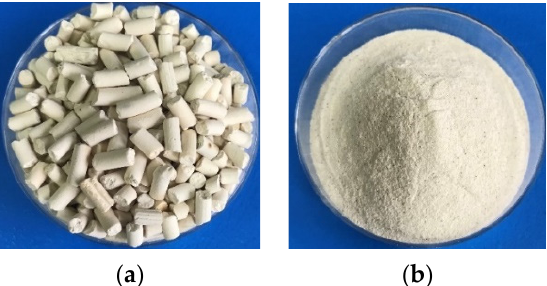
Figure 2. Images of: ( a ) 13X zeolite in pellets form; ( b ) powder of 13X zeolite.